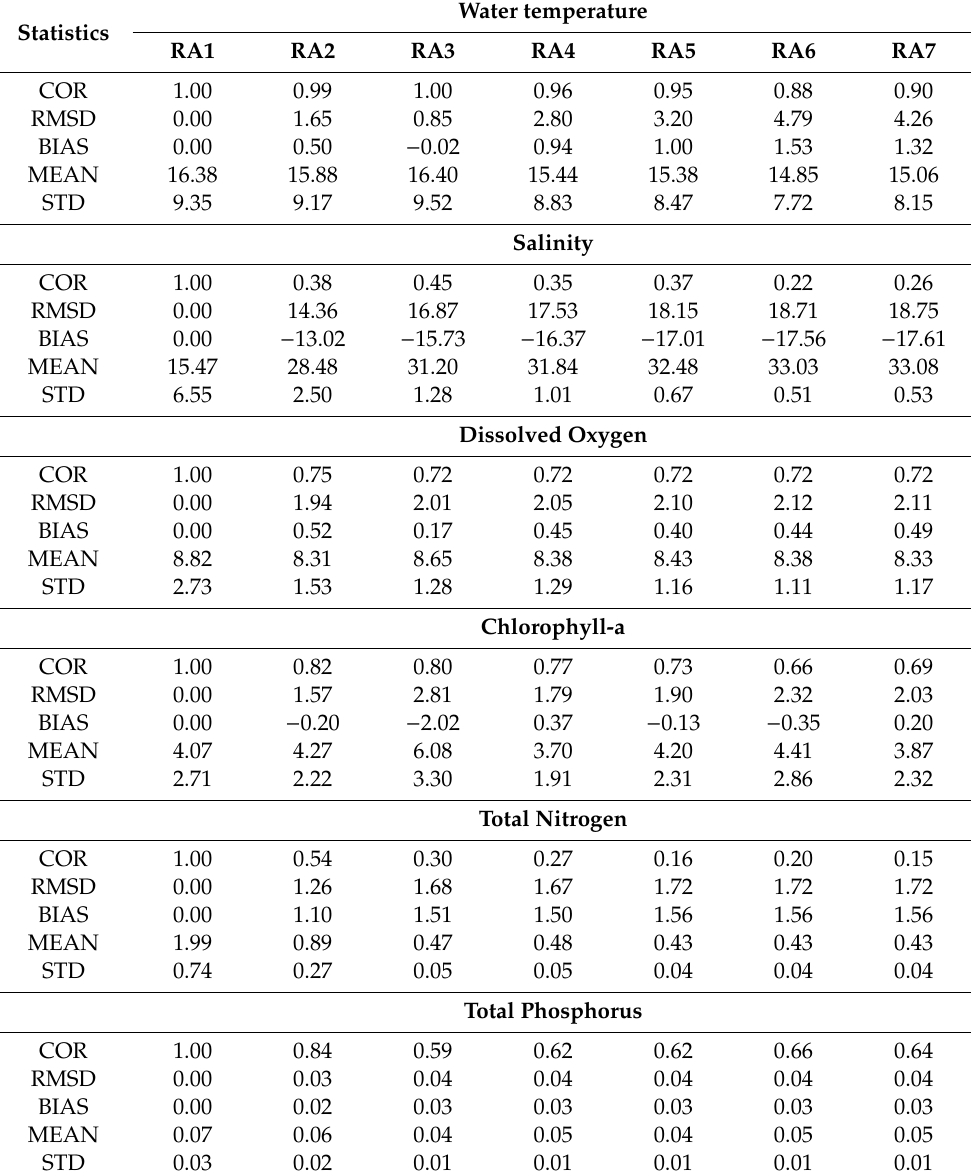
Table 4. Statistical quantities of the time-series distribution for six variables at each optimal point, with representative area 1 (RA1) as a reference